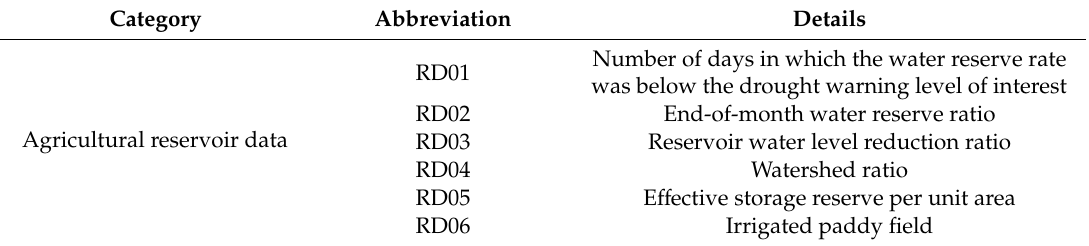
Table 2. Agricultural reservoir data details and abbreviations.